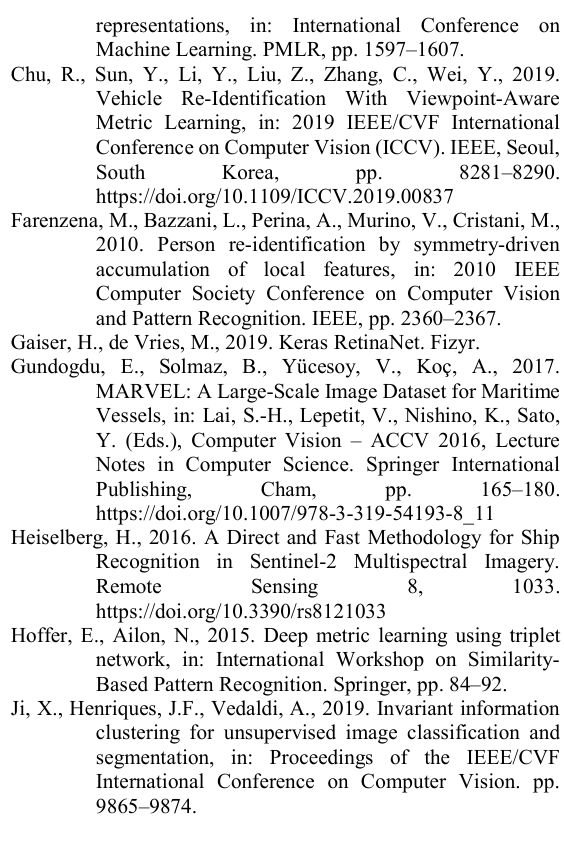
Figure 8. Top-5 ranked vessels (each row shows the available images of each candidate) as retrieved by the Twin network for a specific probe image in the test set (vessel with MMSI 357358000). The green checkmark indicates the rank of the corresponding correct